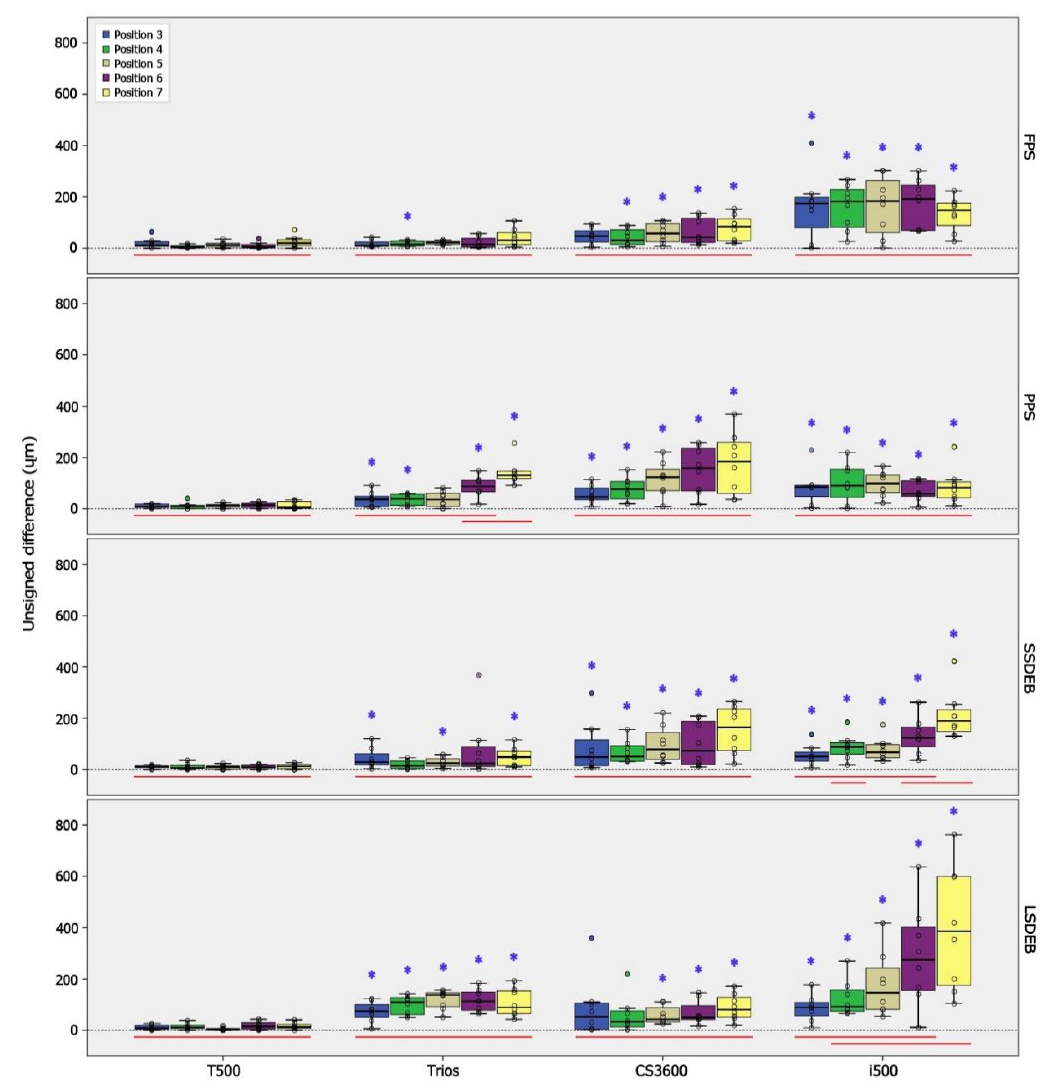
Figure 8. Box plot demonstrating the unsigned difference of experimental models (Right Y -axis) by various scanners ( X -axis). FPS: Full Posterior Support, PPS: Partial Posterior Support, SSDEB: Short Span Distal Extension Base, LSDEB: Long Span Distal Extension Base. Asterisks indicate a statistically significant difference in the intergroup comparison on the same interarch marker position between the laboratory scanner and IOS ( p < 0.05). The solid line demonstrates no significant difference in the intragroup comparison of unsigned differences by post hoc